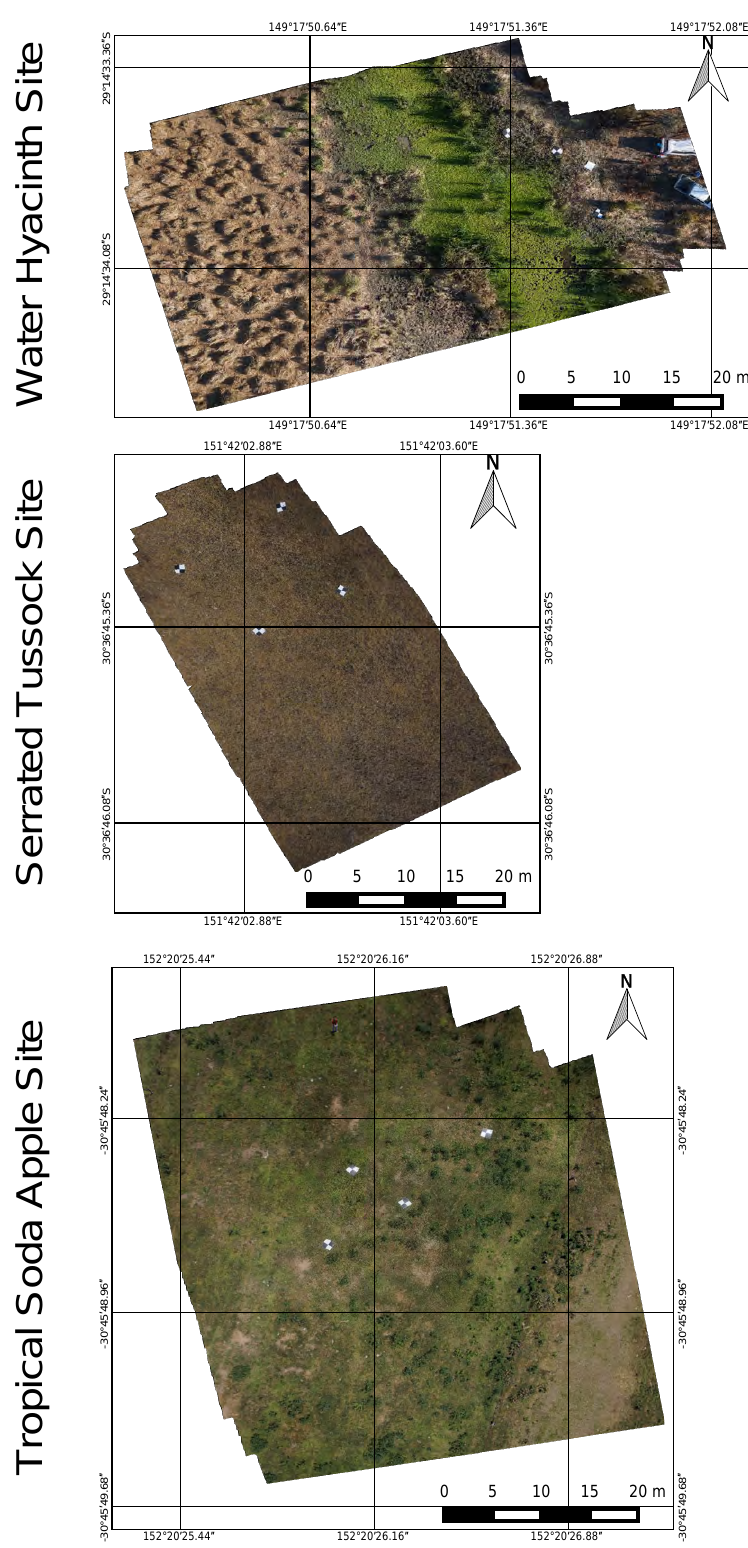
Figure 7. Image mosaic of the surveyed weed sites. Images taken from different flight altitudes were mosaicked, with images captured at higher altitudes providing coverage, whereas images captured at lower altitudes had higher